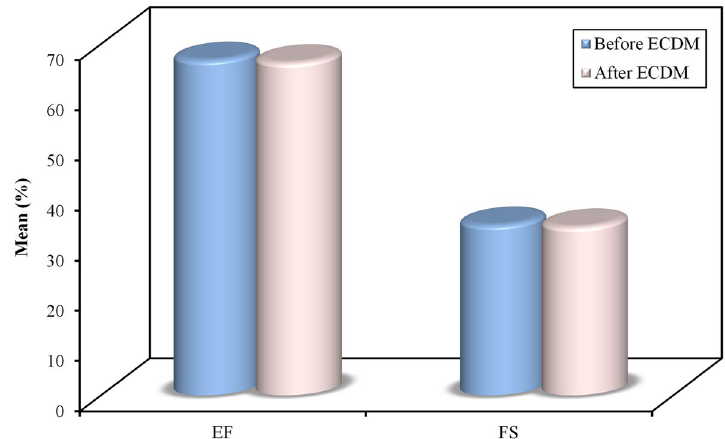
Fig. 1 Compression between the mean of EF and FS before and after ECDM in patients with birth weight